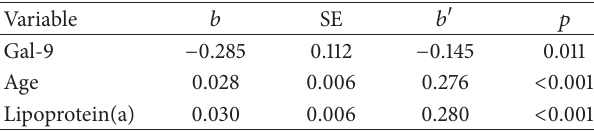
Table3:VariablesindependentlyassociatedwithGal-9,asidentified by multiple regression analysis.